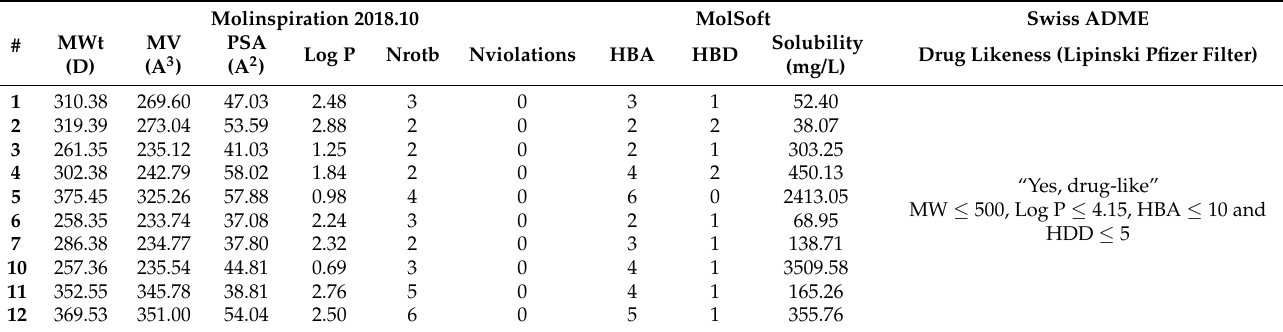
Table 6. In silico ADME pharmacokinetics